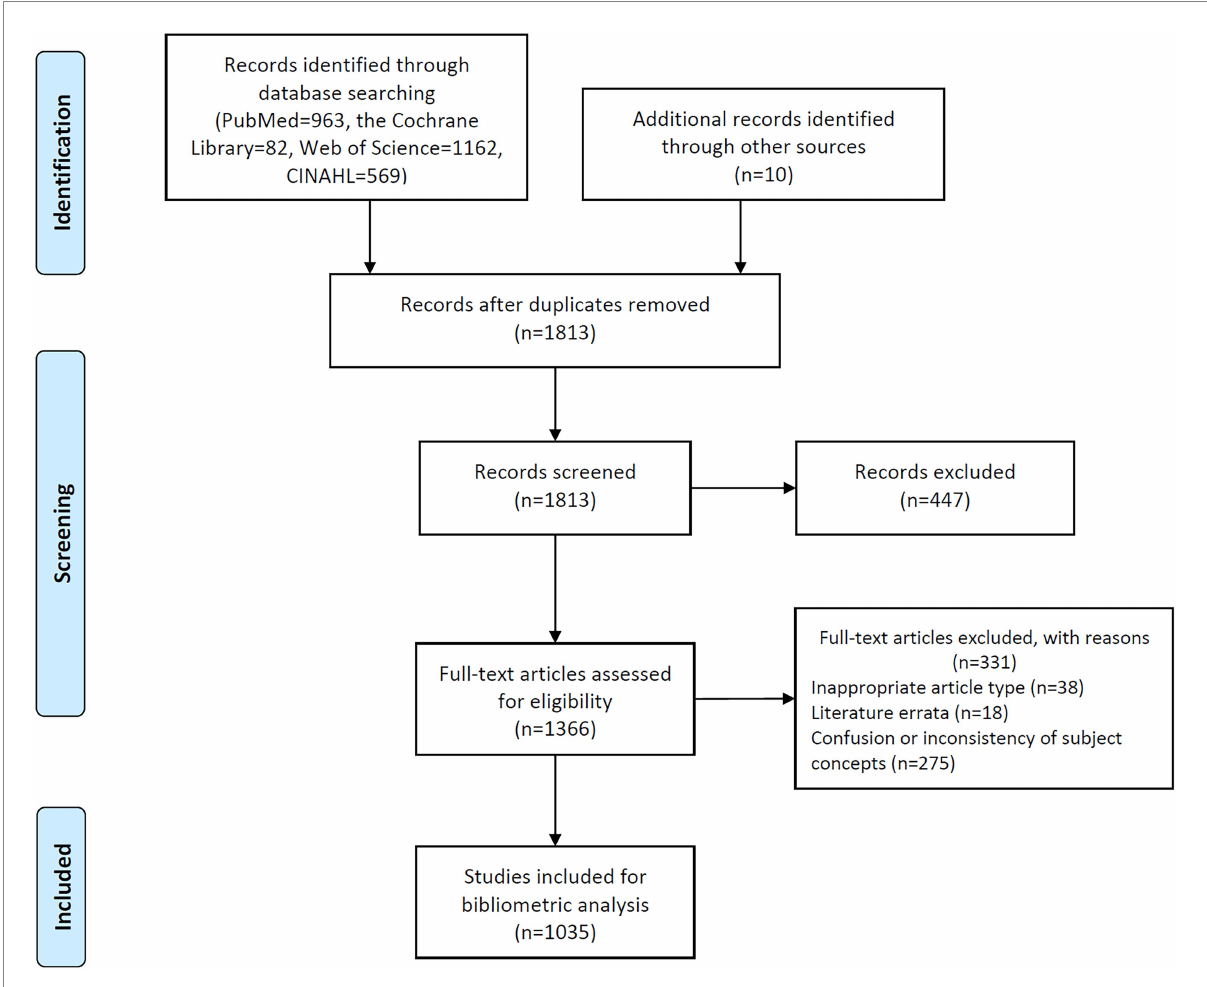
FIGURE 1 Flow chart of search and screening for related studies of